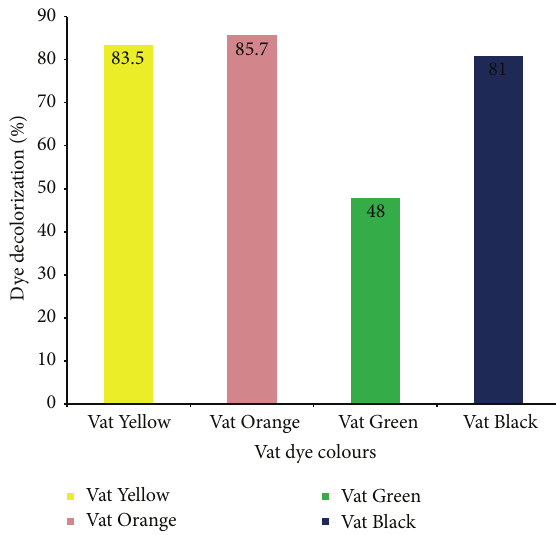
Figure 8: Percentage dye decolourization after 4 h of incubation.